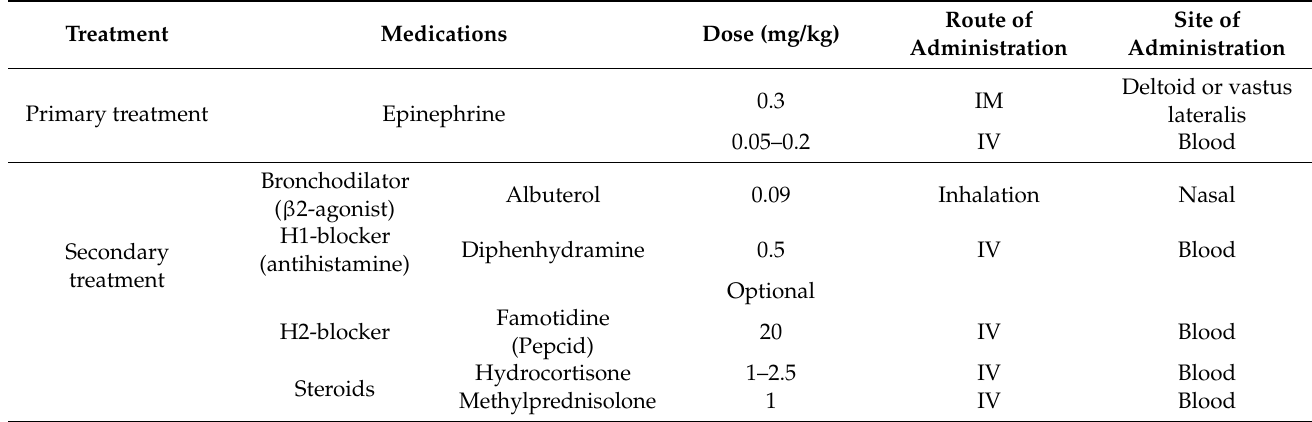
Table 4. Pharmacotherapy management of anaphylaxis/anaphylactoid reactions